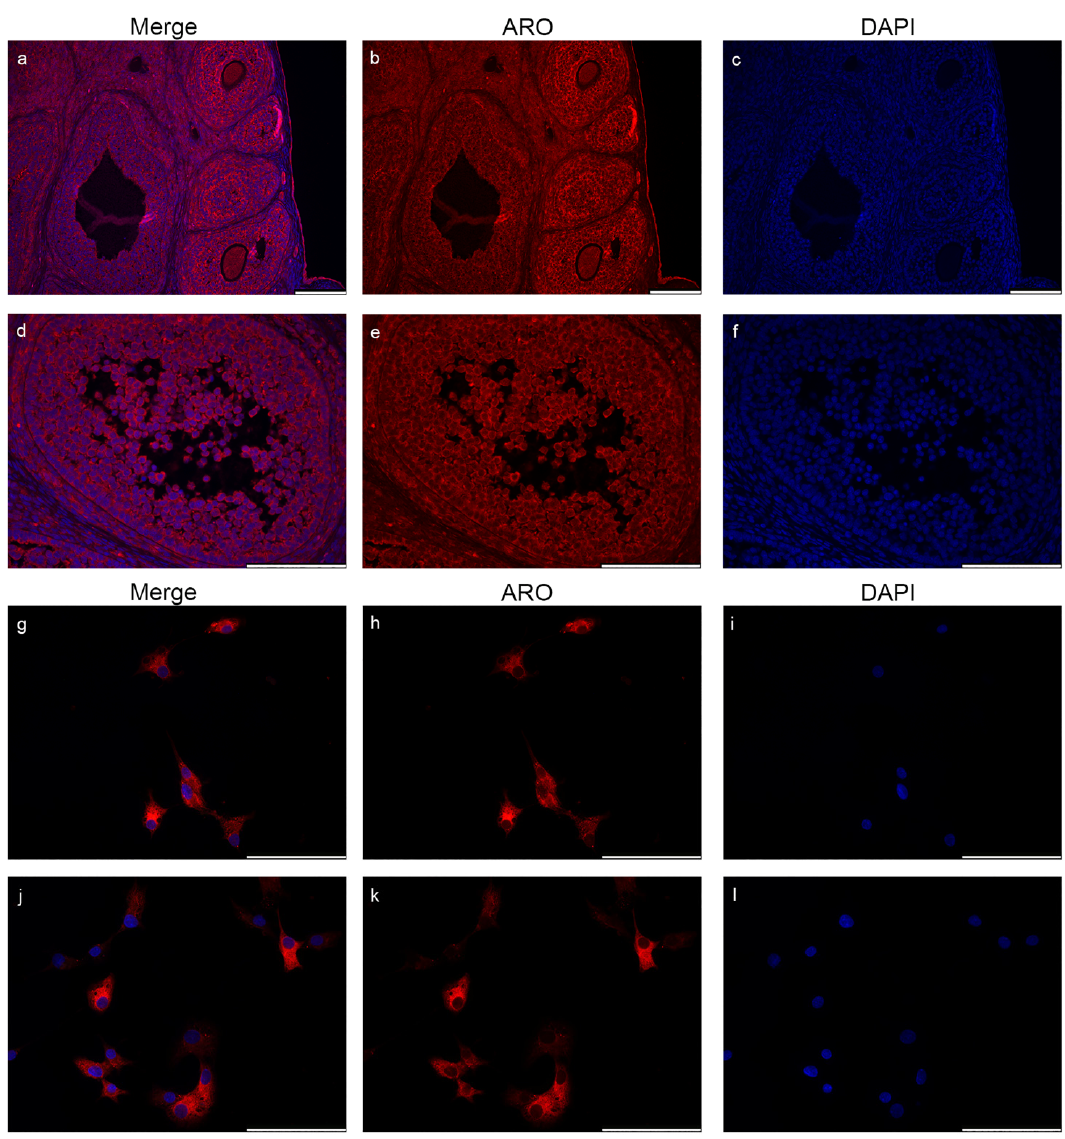
Figure 9. Localization of aromatase in the rat ovary and in human granulosa cells. Immunostaining of rat ovarian tissue sections is presented in images ( a – f ). Immunohistochemistry revealed that Aro (red) is strongly expressed in the whole ovarian tissue during the oestrus cycle but does not colocalize with the nuclear signal (blue). Results from Aro-stained human granulosa cells (red) corroborate the immunohistochemical findings as Aro immunopositivity is abundant in granulosa cells but only in the cytoplasm ( g – l ). Scale bar: 100 μ m.